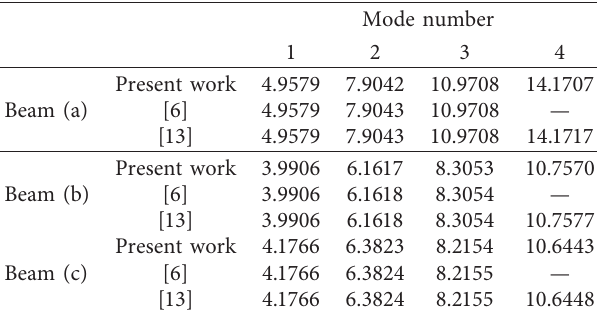
Table 7: The first four eigenvalues for the three